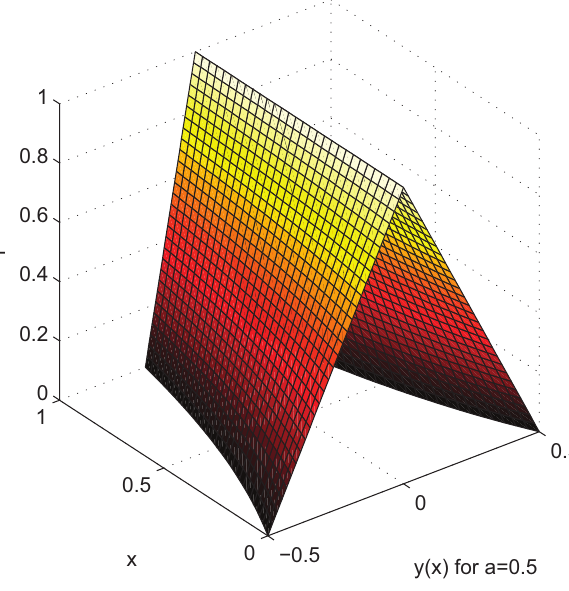
Figure 3. The solution of FDE under case 2 consideration.